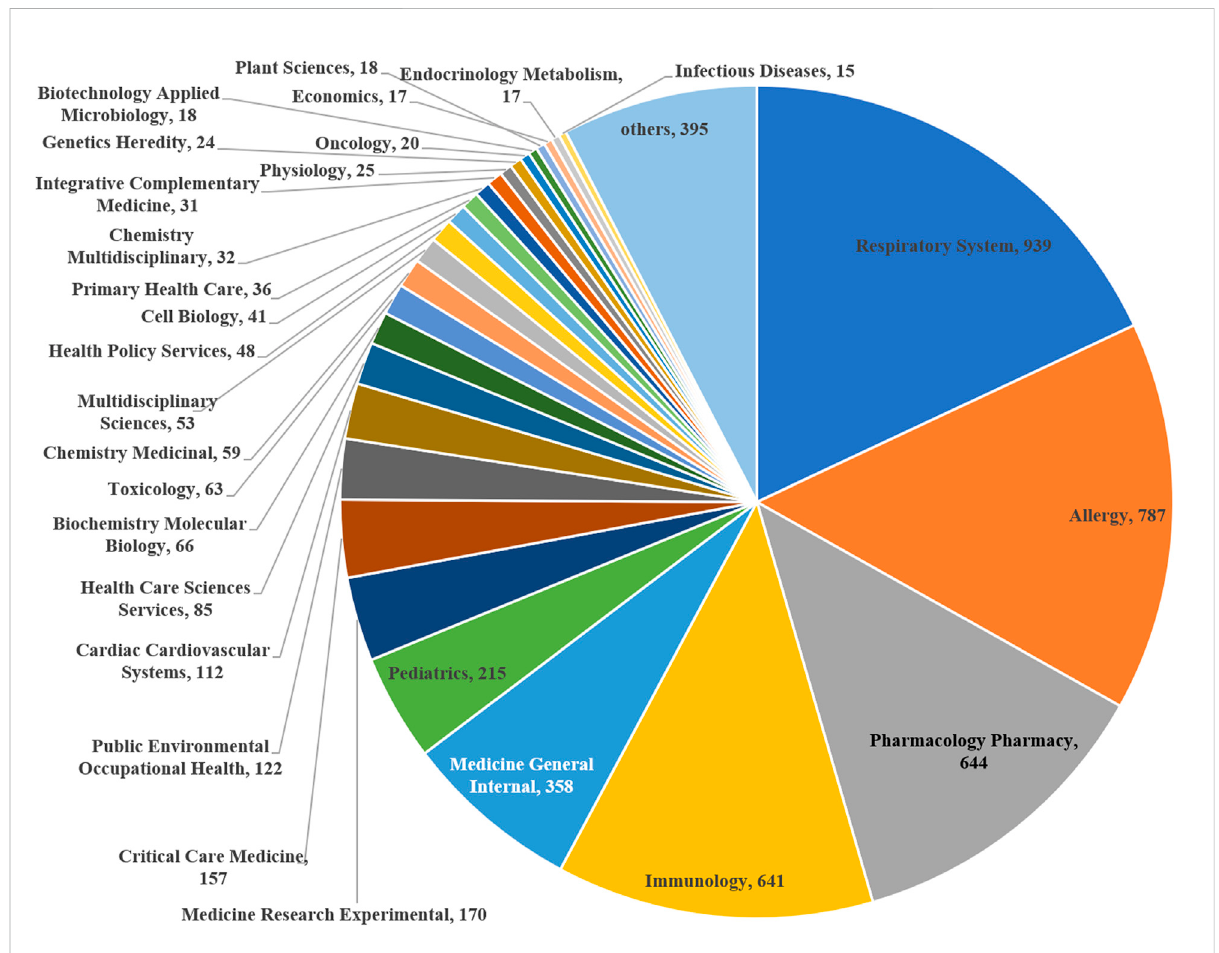
FIGURE 4 Research areas of asthma drug-related studies that were published from 1982 to